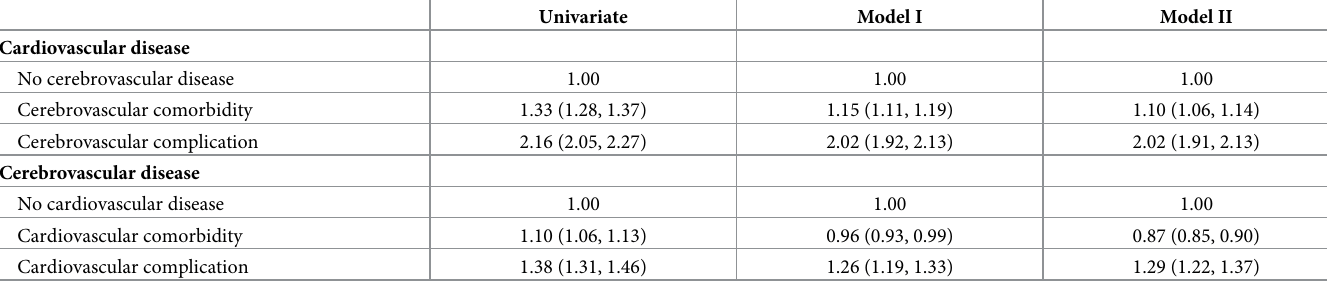
Table 2. Univariate and multivariable multilevel logistic regression results for in-hospital